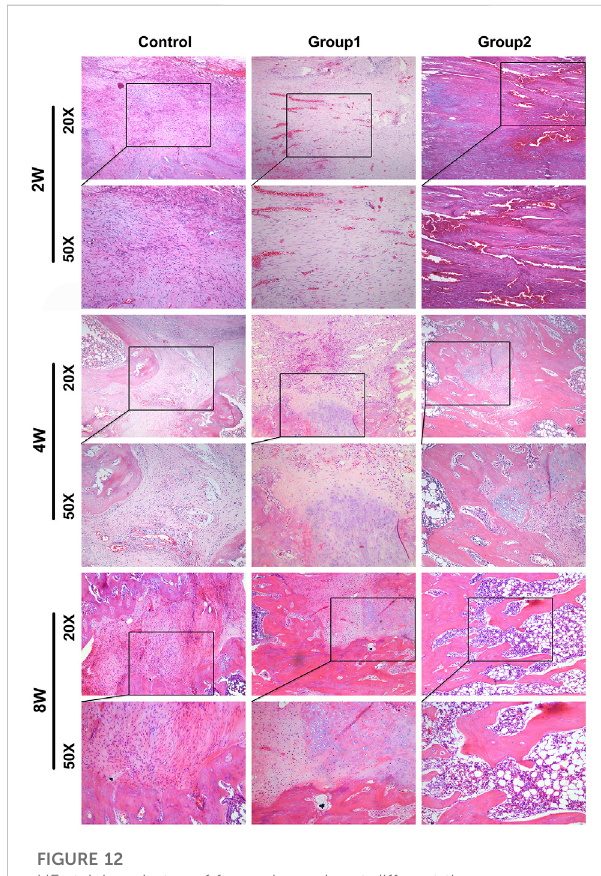
FIGURE 12 HE staining photos of femoral samples at different time points